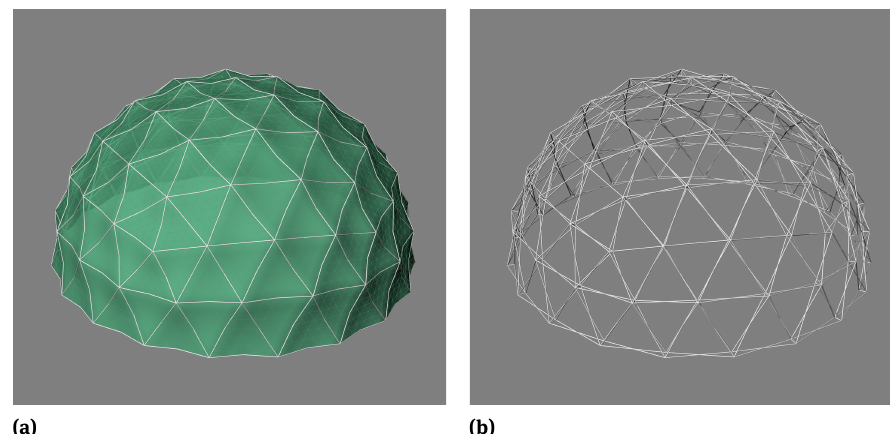
Figure 14: a) Initial dome membrane model; b) Initial scissor structure